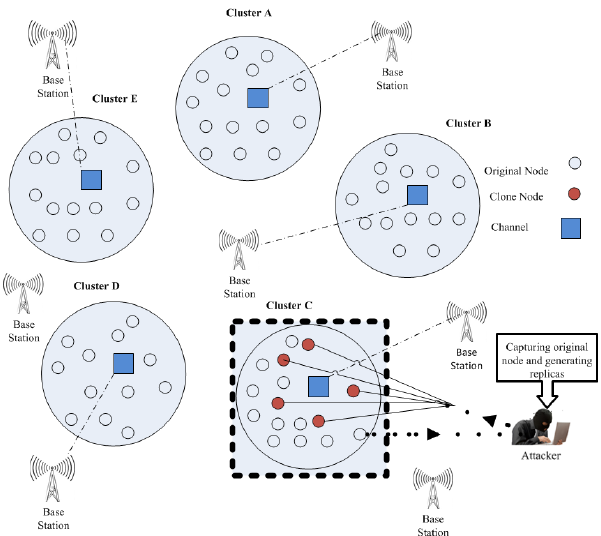
Figure 4. Cluster level detection in a Mobile Wireless Sensor Network